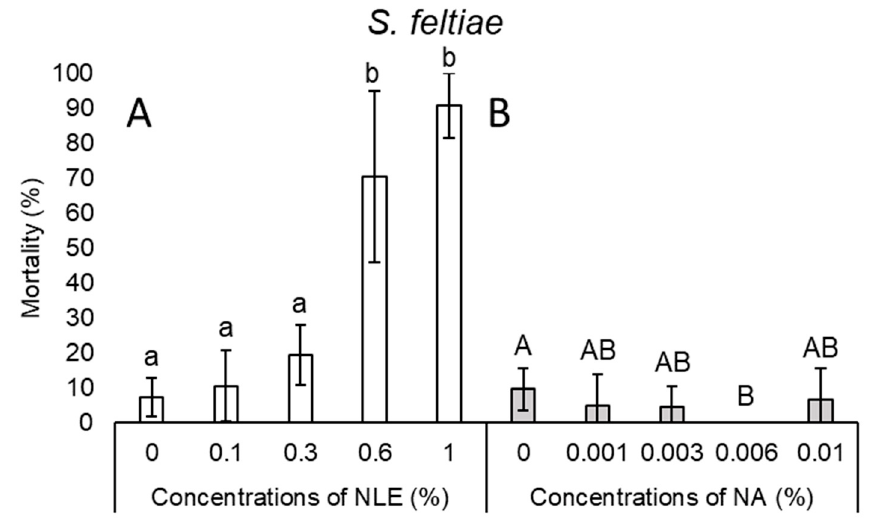
Figure 3. Mortality after 24-h exposure time of Steinernema carpocapsae juveniles of 0.1%, 0.3%, 0.6%, and 1% NLE ( A ) and 0.001%, 0.003%, 0.006%, and 0.01% of NA ( B ). (One-way ANOVA, Mann–Whitney U test ( A ), Tukey’s pairwise comparisons ( B ); the same letters indicate no significant difference at p < 0.05 level).